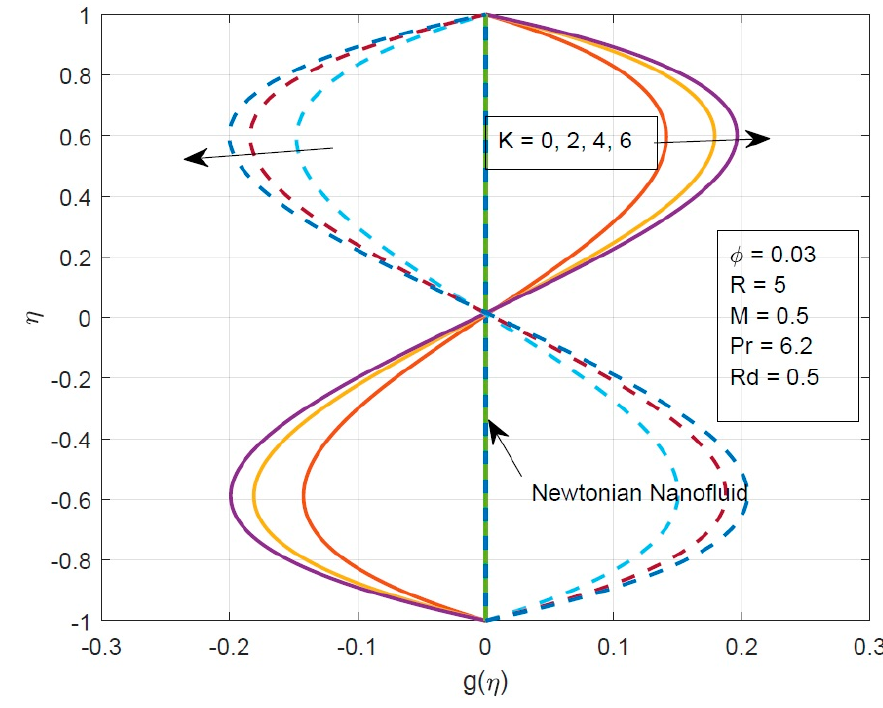
Figure 4. The effect of the micropolar parameter on the micro-rotation.